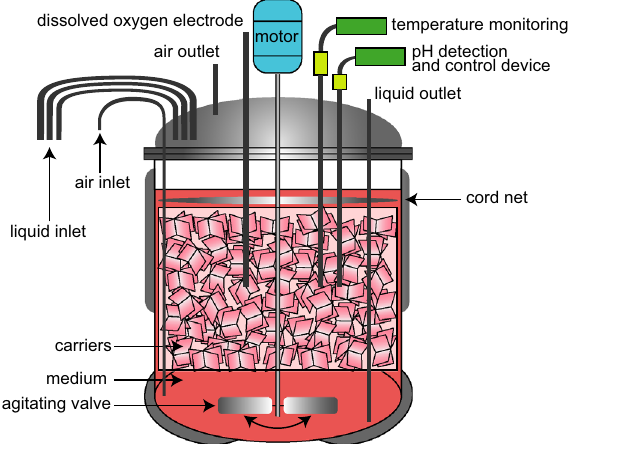
Figure 7. Schematic of the basket